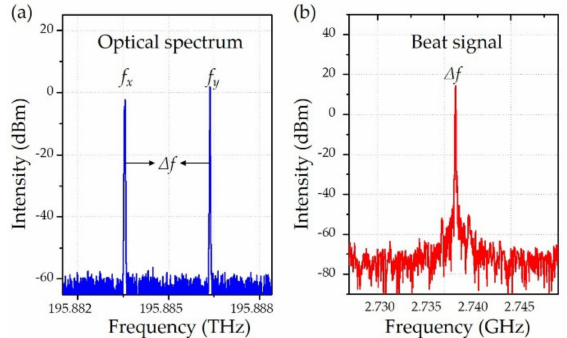
Figure 3. Output optical and radio-frequency spectrum of the fiber laser sensor. ( a ) Spectrum of two polarization modes measured with an optical spectrum analyzer. ( b ) Spectrum of beat signal measured by a radio-frequency (RF) analyzer after the photodetector. Figure adapted with permission from Ref.